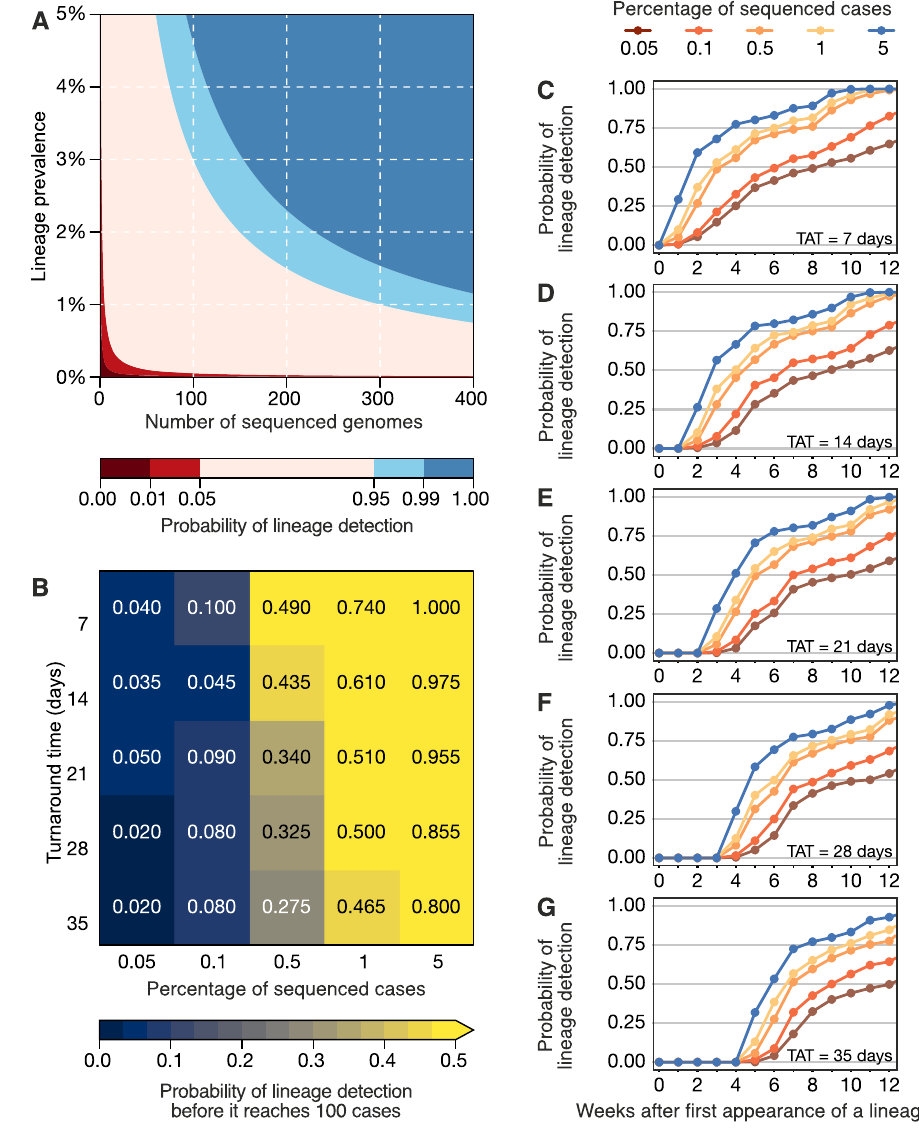
Fig. 3 | Detectionof SARS-CoV-2 lineages under different genomic surveillance scenarios, assuming random sampling. A The probability of detecting at least one genome of a rare lineage under different sequencing regimes. B Relative importance of decreasing genomic sequencing turnaround time (TAT) versus increasingsequencingpercentage,measuredastheprobabilitythatagivenlineage